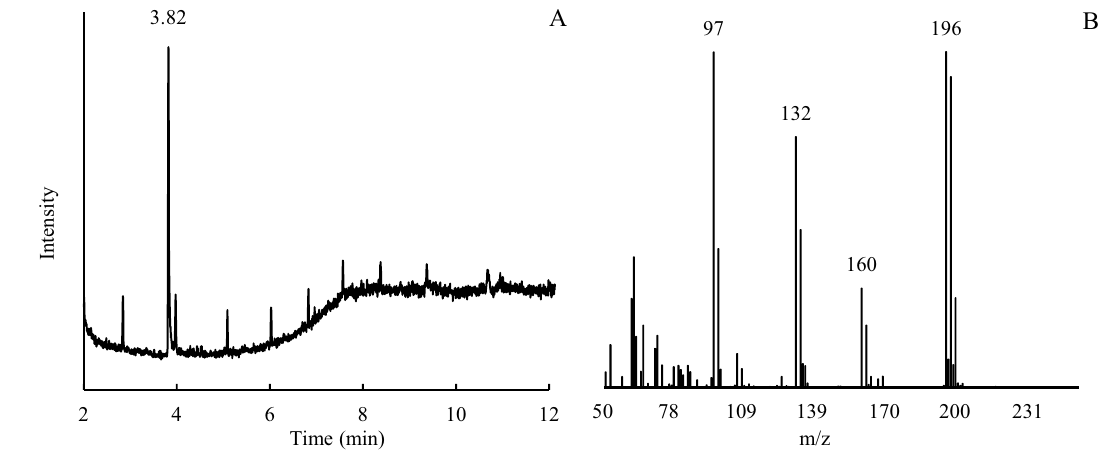
Figure 7. The GC–MS maps of desorbing 2,4,6-TCP from aging bush biochars in the solution ( A ) GC map, ( B ) MS